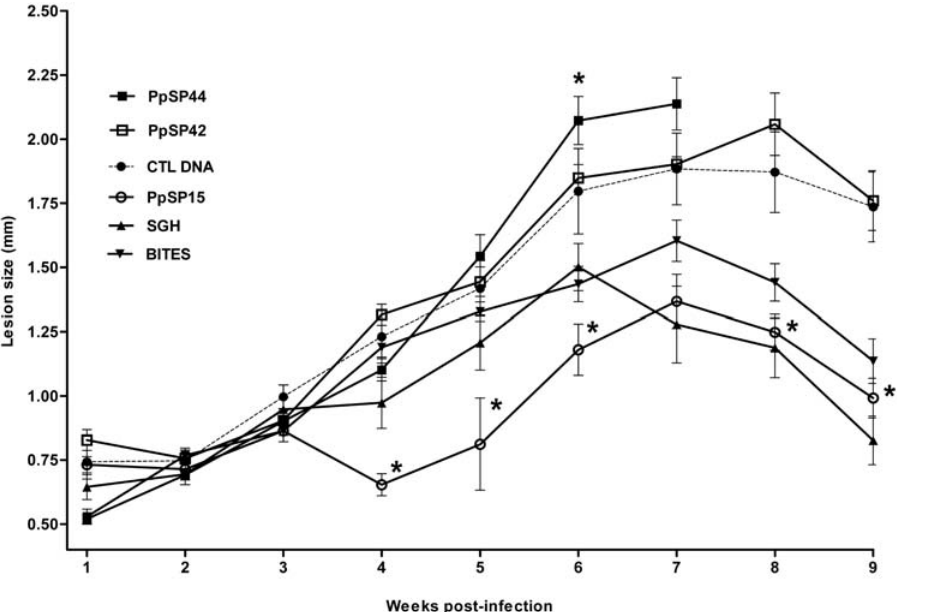
Figure 2. DNA immunization with distinct DTH-inducing salivary proteins modulates the course of infection with L.major . Mice immunized in the right ear with CTL DNA ( $ ), PpSP15 ( # ), PpSP42 ( % ), PpSP44 ( & ), SGH ( m ) or pre-exposed to bites of uninfected sand flies ( . ) were challenged in the left ear with 500 L. major metacyclics and 0.5 pairs of SGH. Due to the extensive ulceration of the ears in mice immunized with PpSP44, lesion size measurements could not be performed beyond seven weeks after challenge. The symbols represent the mean 6 the SEM for ten mice per group. Asterisks indicate statistical significance ( p , 0.05) compared to mice immunized with CTL DNA. Data are representative of three different